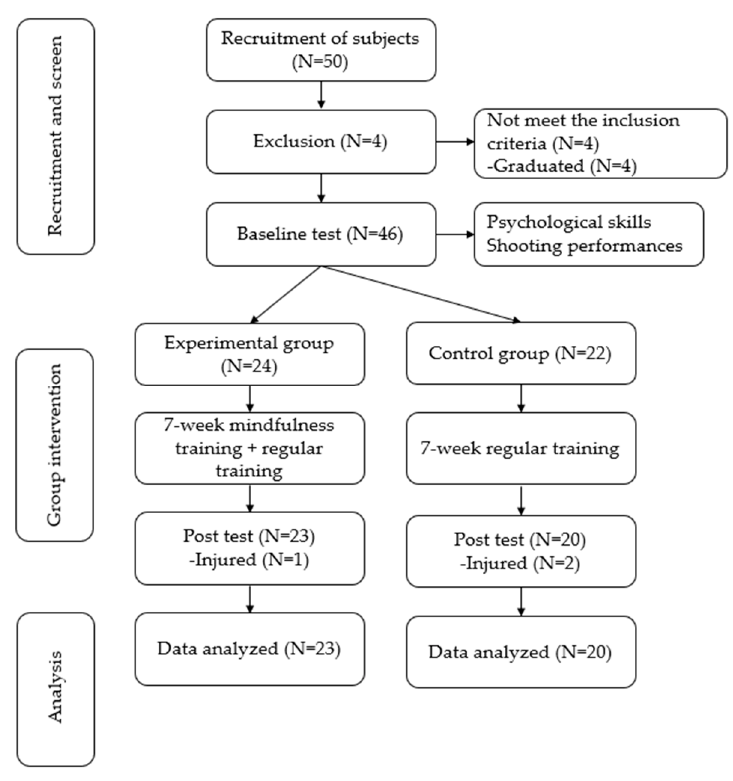
Figure 1. Study flow chart.